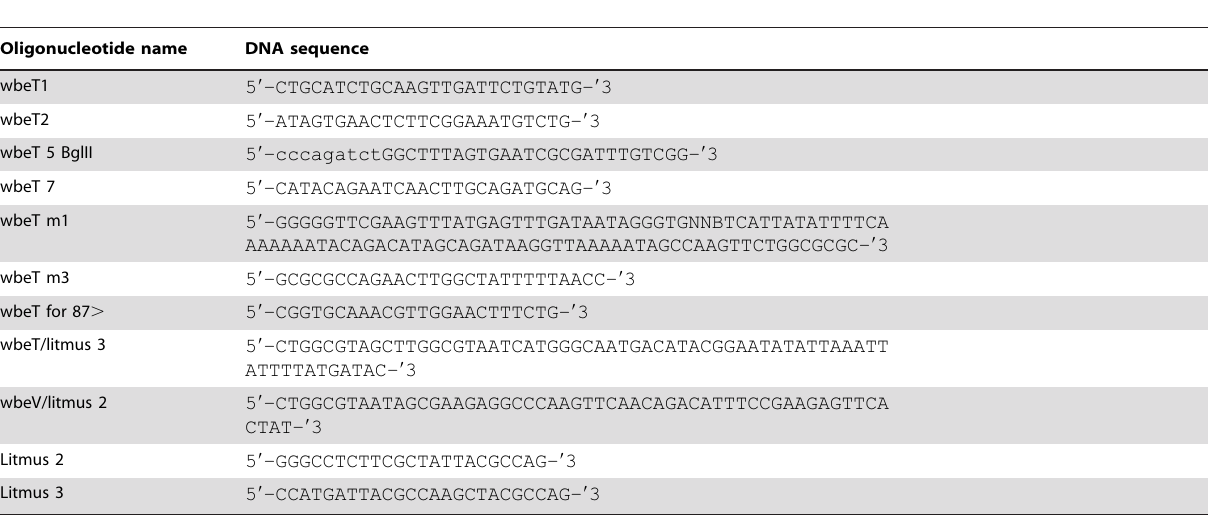
Table 3. Primer and Oligonucleotide used for cloning and analysis of the wbeT gene.